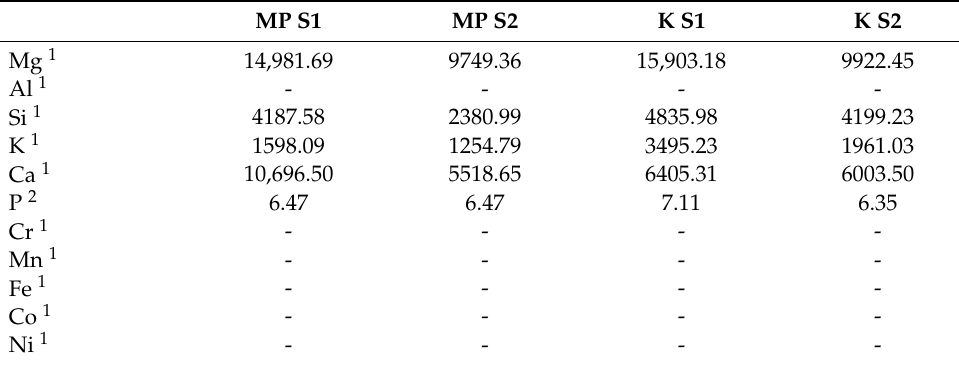
Table 2. Concentration of elements measured in samples collected during different time periods (S1 and S2) from Mikri Prespa (MP) and Kastoria (K) lakes. MP